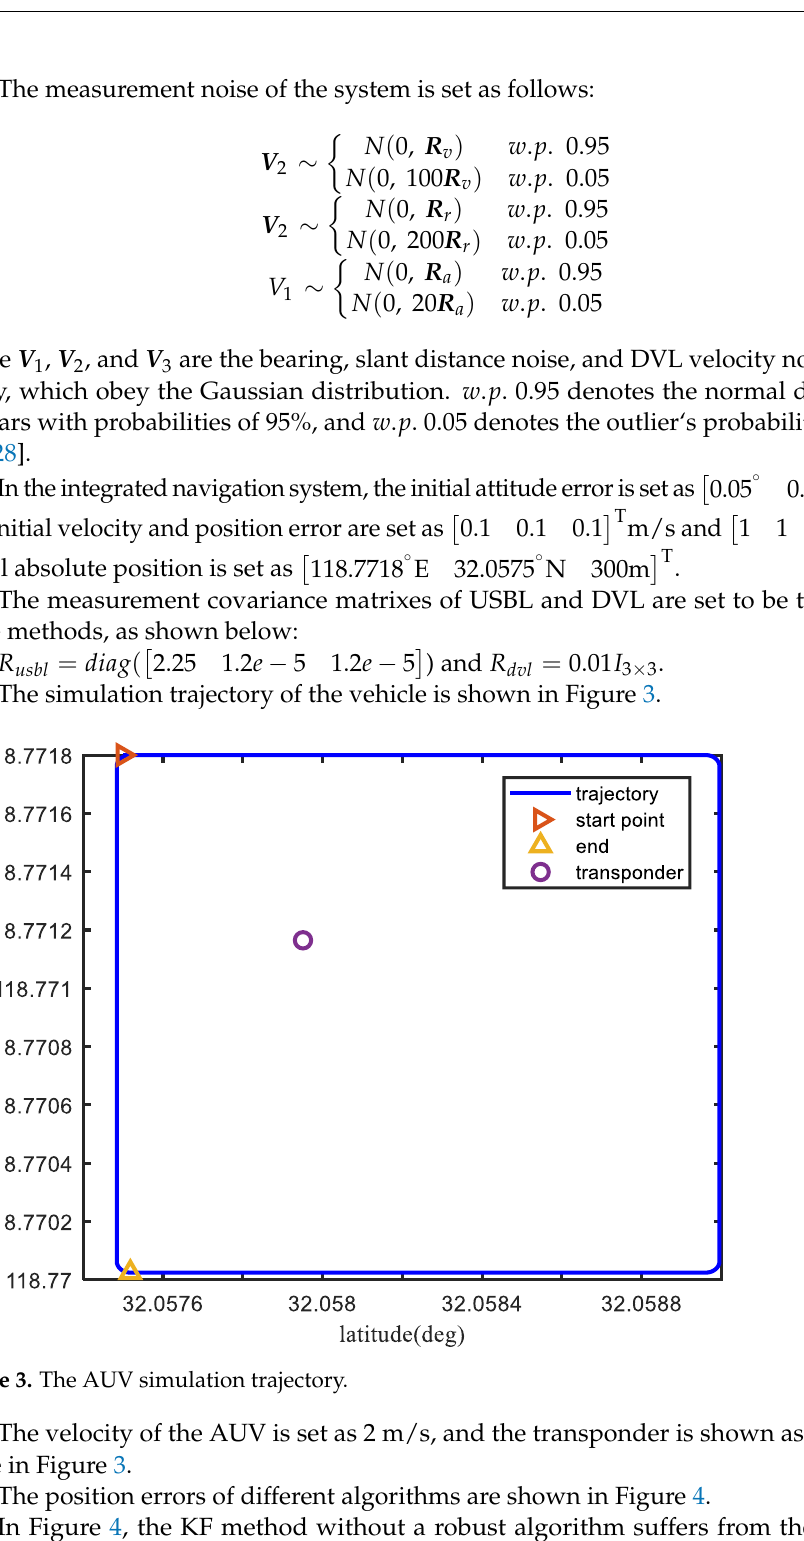
Figure 4. Position error of different algorithms. In Figure 4, the KF method without a robust algorithm suffers from the influence of outliers. The HKF method can suppress the influence of outliers. The Huber-based ap- proach is limited in its ability to handle large outliers. Thus, it shows a worse performance than the proposed method. Even the traditional FGO method shows a worse performance